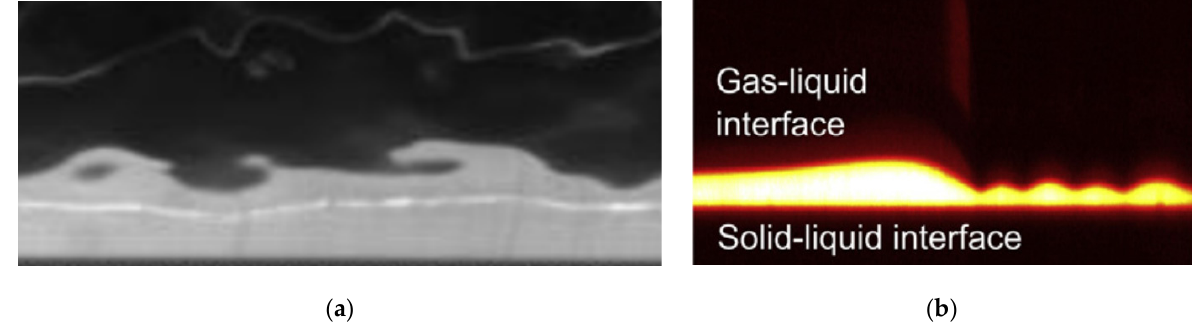
Figure 4. Raw PLIF images illustrating the mirror effect: ( a ) Falling film in a pipe under 𝜃 = 70°. The true and false film images are separated by a bright line; they are of different size but the same brightness [68]. Shadows cast by pipe non-uniformities and broken at the bright line can be seen; ( b ) Falling film on a plate under 𝜃 = 35°. The true film image is bright; the false film image above it is about the same size but much darker [54].